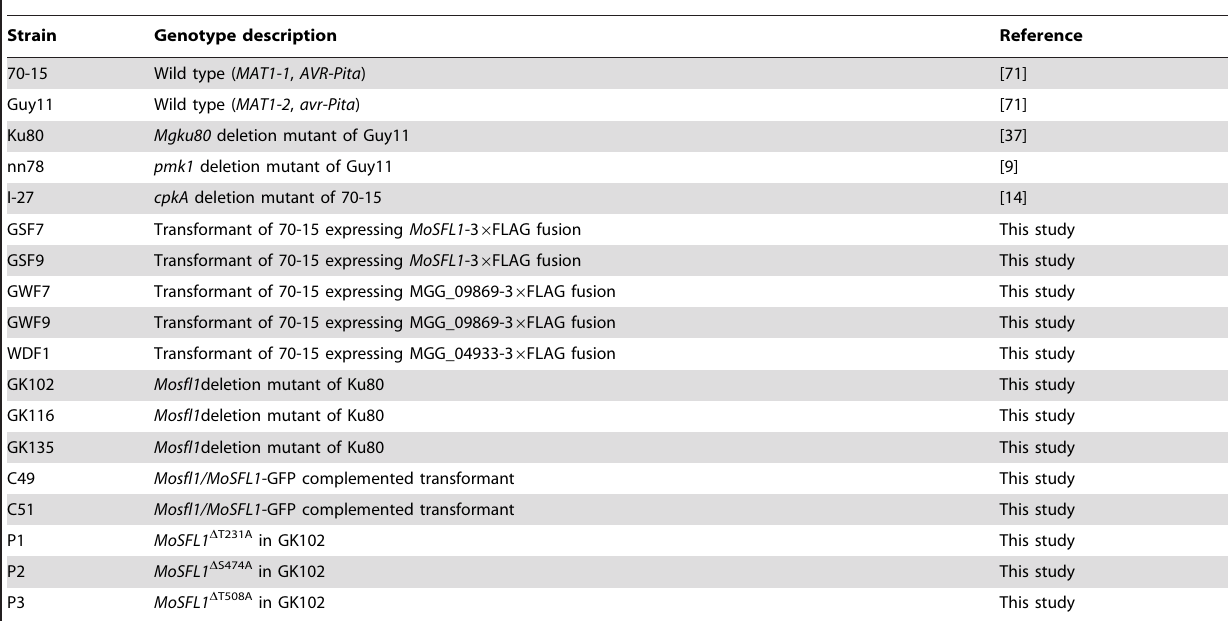
Table 1. Wild-type and mutant strains of Magnaporthe oryzae used in this study.